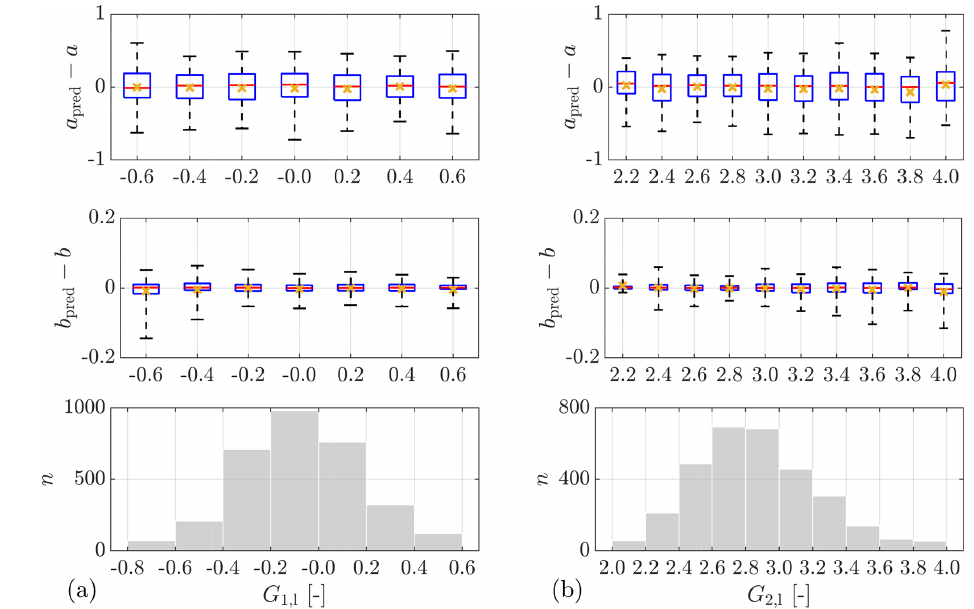
Figure 14. Prediction errors of a (case 6) and b (case 11) from Lidar Complex with respect to the values of predictors. (a) Skewness of lidar-measured wind speed G 1 , l . (b) Kurtosis of lidar-measured wind speed G 2 , l . n is the sample size. The bottom and top of the boxes indicate the first and the third quartiles, i.e., 25th and 75th percentile, respectively. The lower and upper whiskers show the 5th and 95th percentiles. The red line and the yellow cross in the middle indicate the median and mean value, respectively.